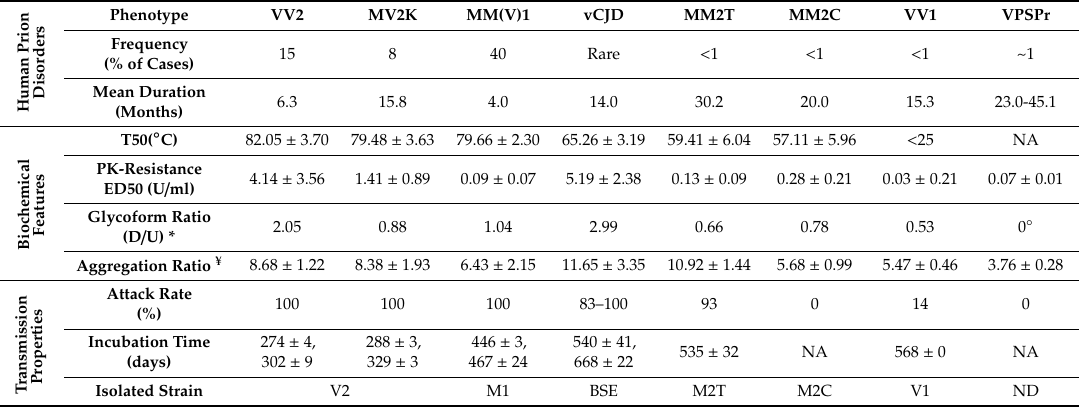
Table 1. Comparison of clinical, biochemical and transmission data among the sporadic CJD (sCJD) subtypes, variant CJD (vCJD) and variably protease-sensitive prionopathy (VPSPr) (adapted from